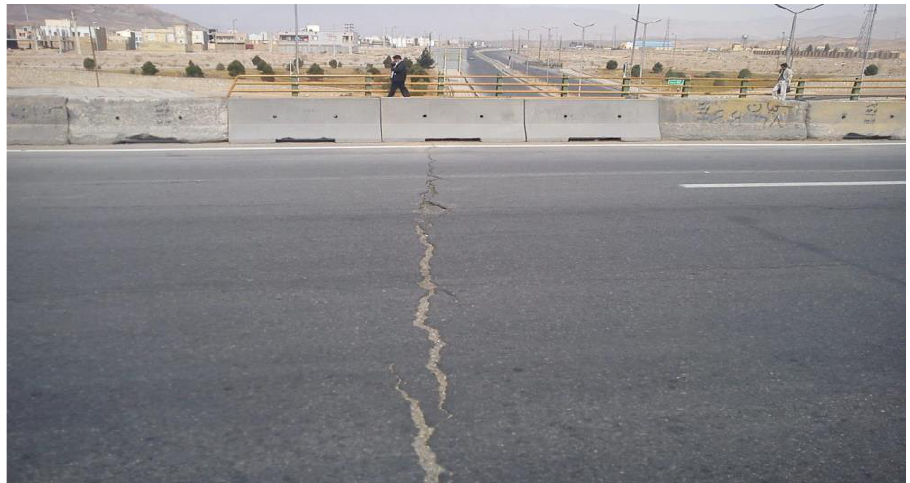
Appl. Sci. 2021 , 11 , x FOR PEER REVIEW Figure 7. An example of minor cracking in the wall of the bridge No. 1. Figure 7. An example of minor cracking in the wall of the bridge No. 1.